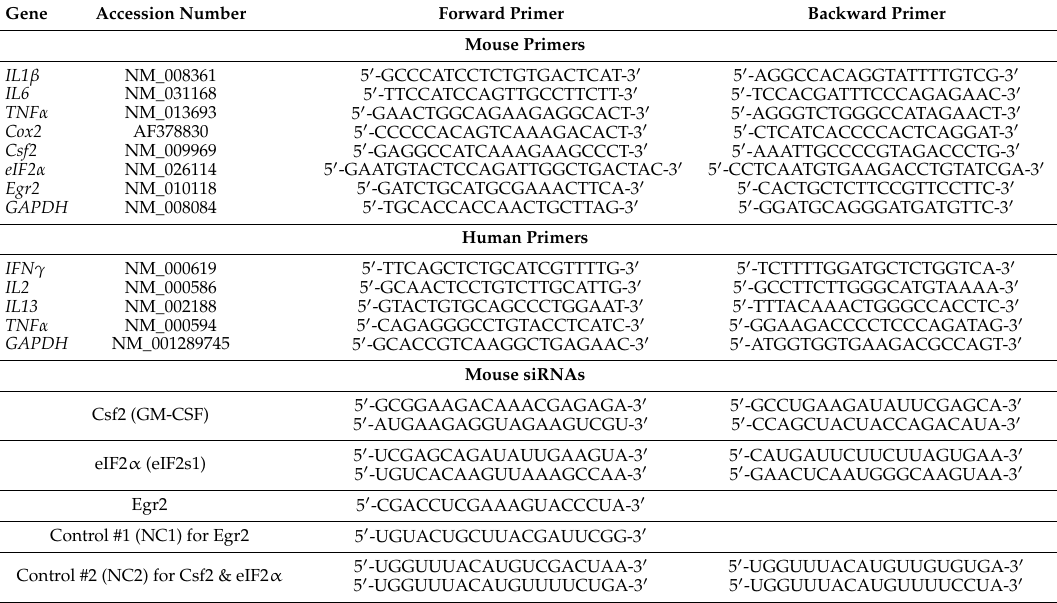
Table 3. Real-time polymerase chain reaction (PCR) primers and siRNAs used in this